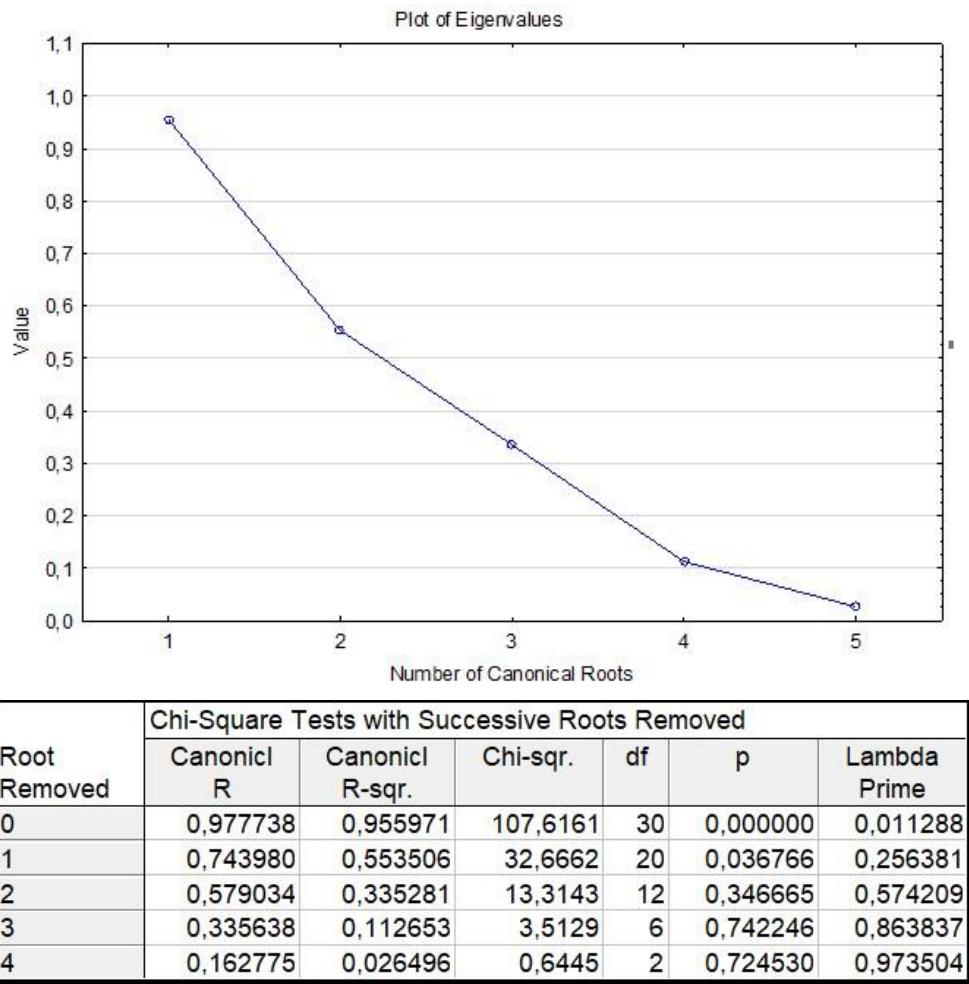
Figure 2. Graph and Table of Eigenvalues of Canonical Roots